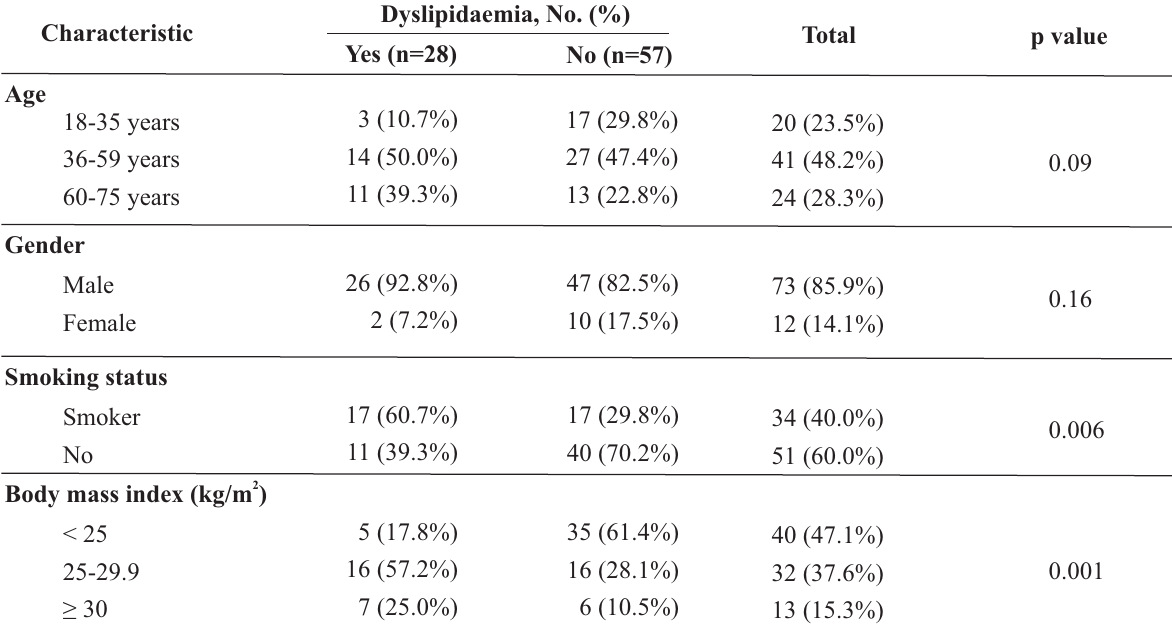
Table 1: Demographic characteristics of the study participants